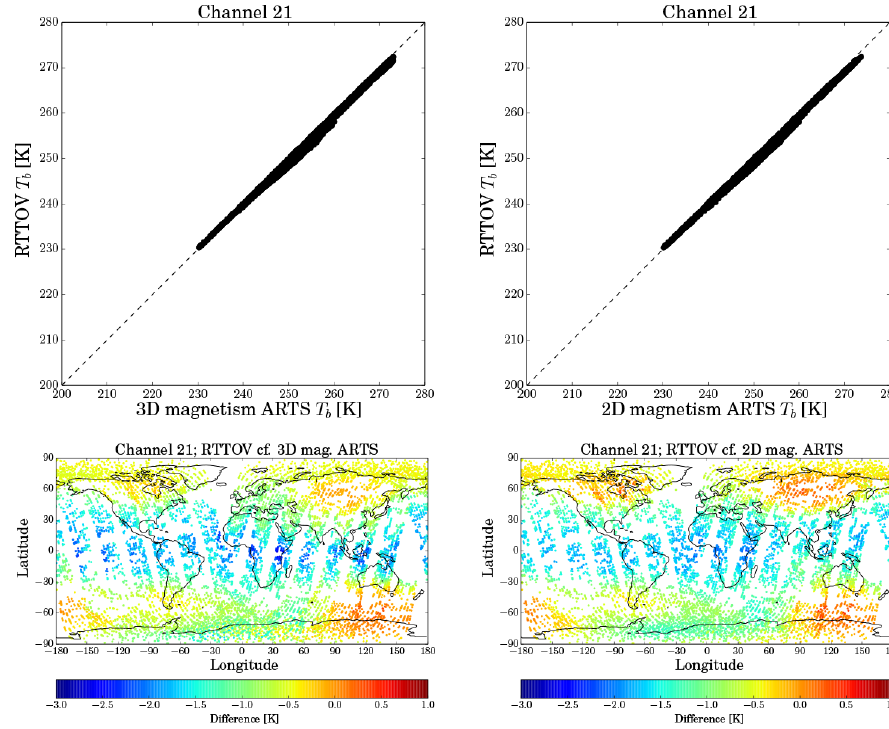
Figure 8. Channel 21 comparison of RTTOV and ARTS simulations as for Fig. 6 but with a fixed color